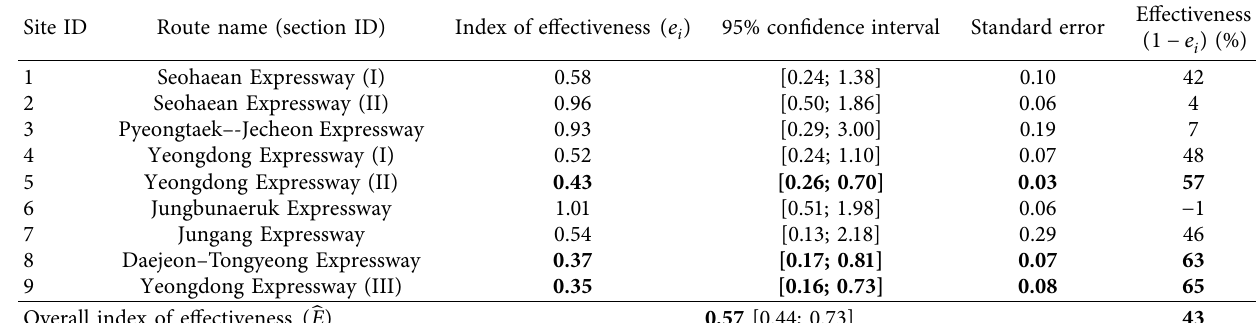
Table 3: Effectiveness of SSES at all study sites.